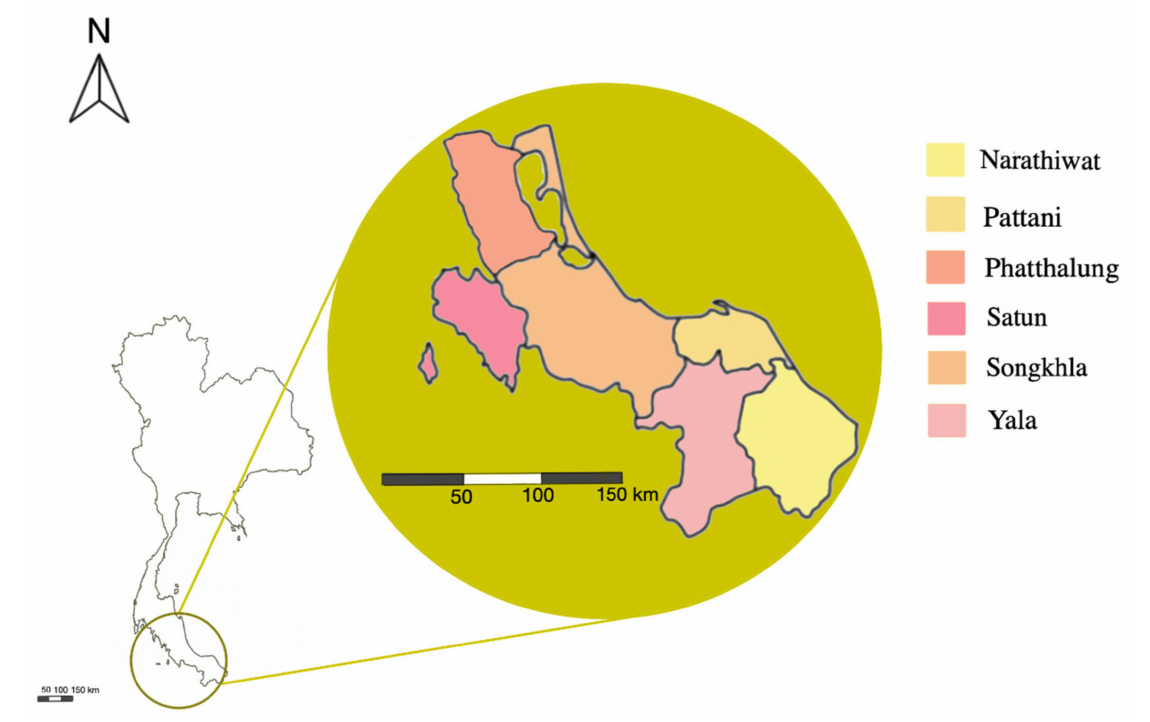
Figure 1. Location of goat farms participating in the present study. A total of 646 goats were selected from 61 goat farms in Narathiwat ( n = 10), Pattani ( n = 7), Phatthalung ( n = 6), Satun ( n = 10), Songkhla ( n = 18), and Yala ( n =